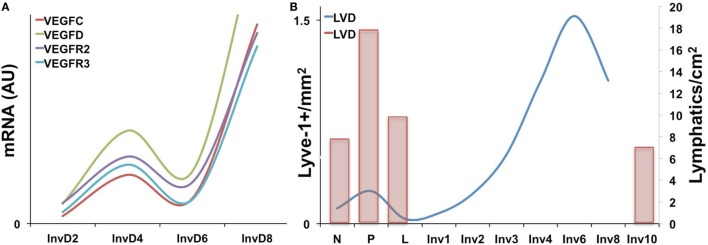
(A) Pro-lymphangiogenic growth factor gene expression, as measured by qPCR is increased during early and late involution in whole rat mammary tissues [adapted from Lyons et al. (38)]. (B) Lyve-1+ lymphatic vessels per area (left axis) is increased during pregnancy and again during involution in mouse mammary tissues with peak levels observed at day 6. (Right axis) A previous study showing a similar increase in Prox-1+ lymphatic vessels during pregnancy as well as levels at involution day 10 [adapted from Betterman et al. (91)].